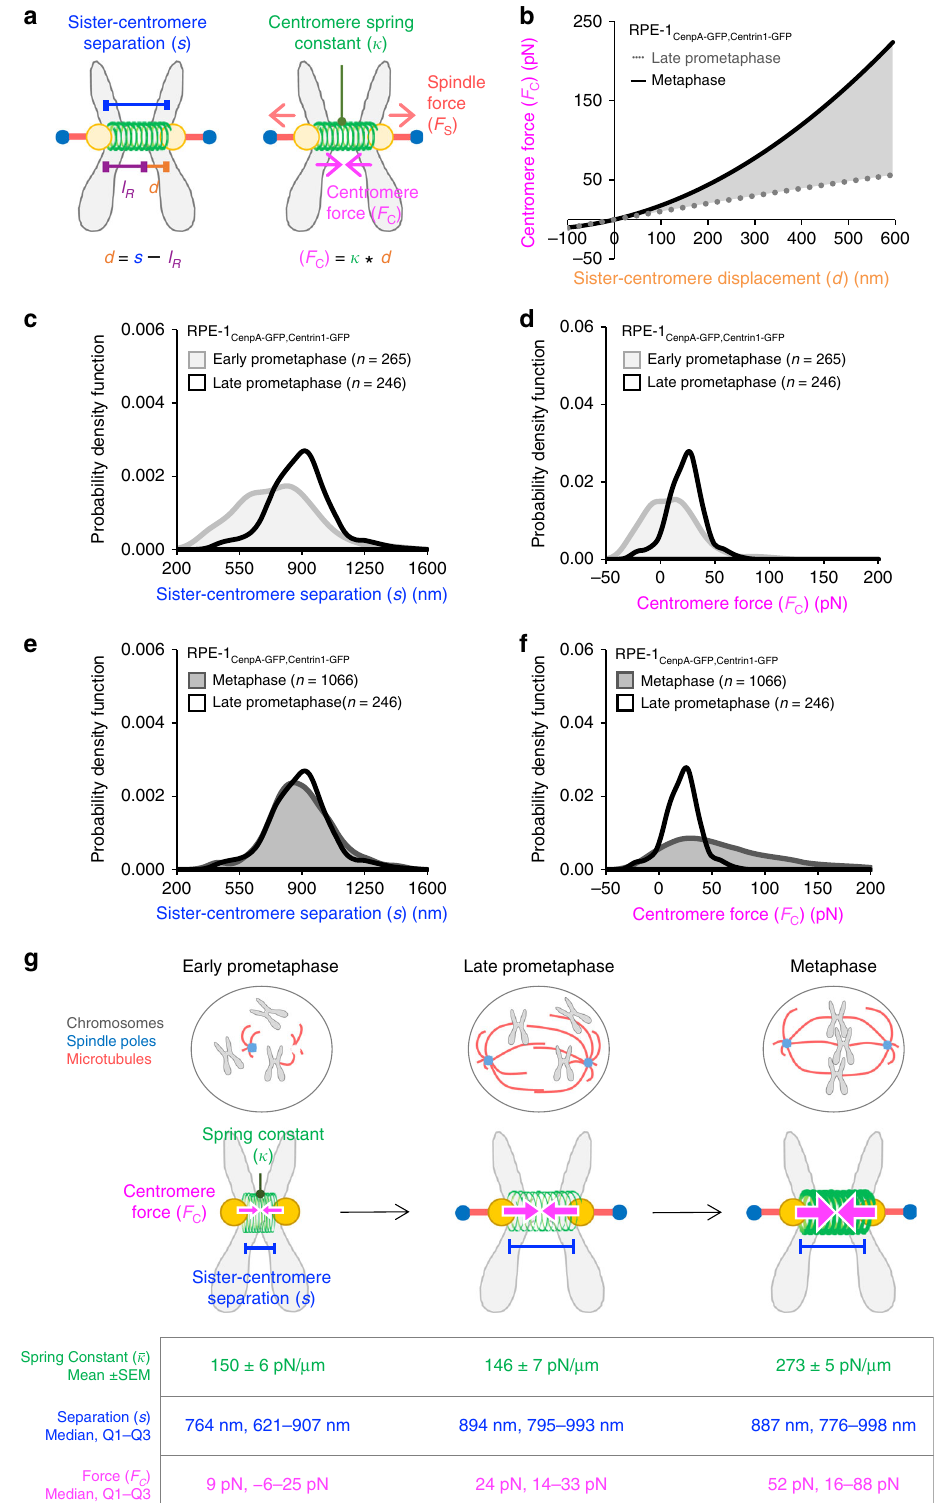
Chromosomes Spindle poles